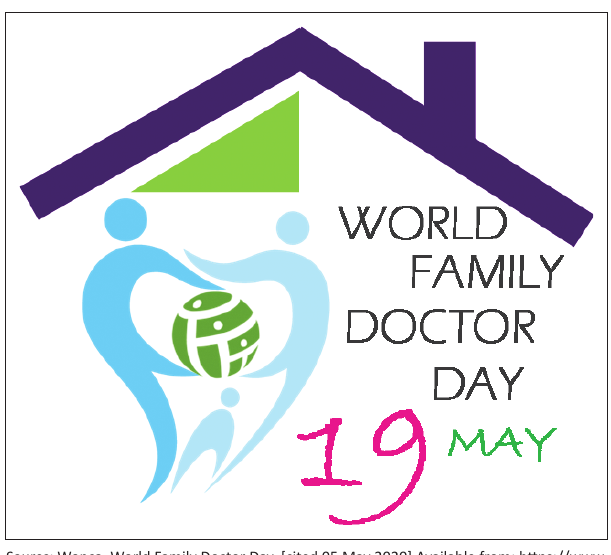
FIGURE 2: Wonca logo for World Family Doctor